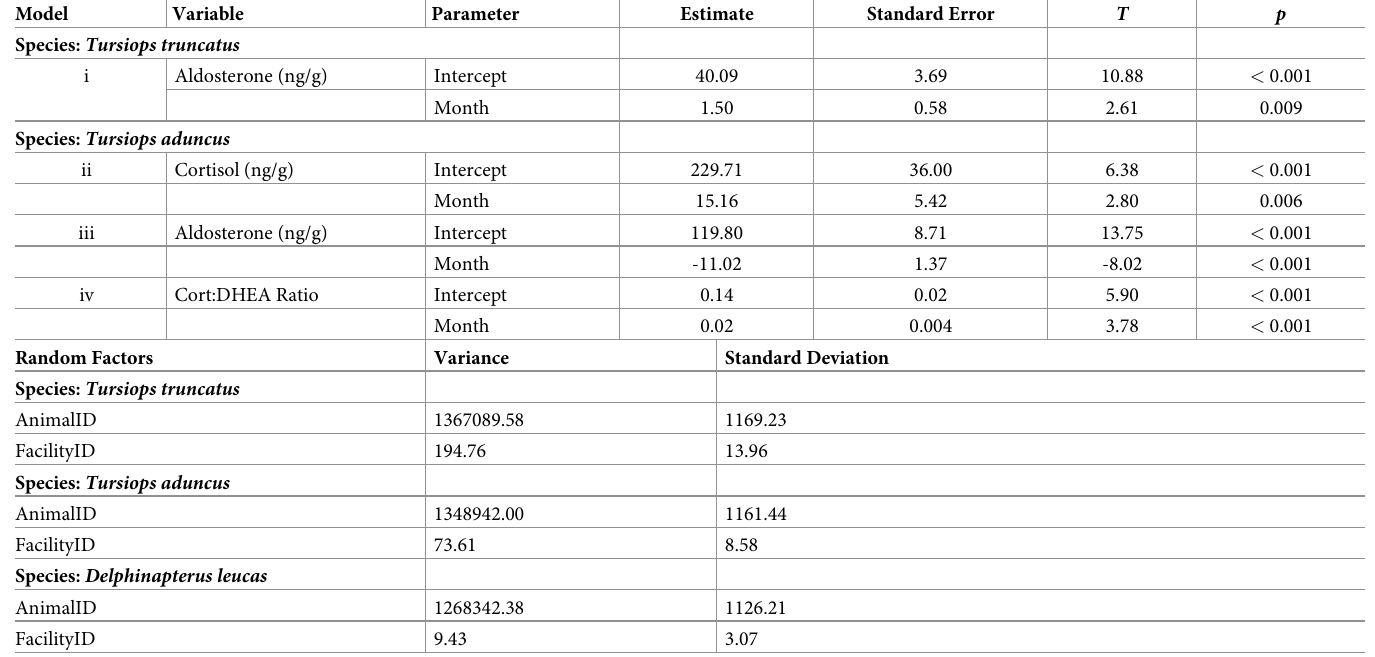
Table 3. Model estimates for predicting fecal hormone values. Mixed models included the explanatory variables found to be significant predictors. Possible fixed effects included: sex, age, age 2 , and month. Random effects included: animalID and